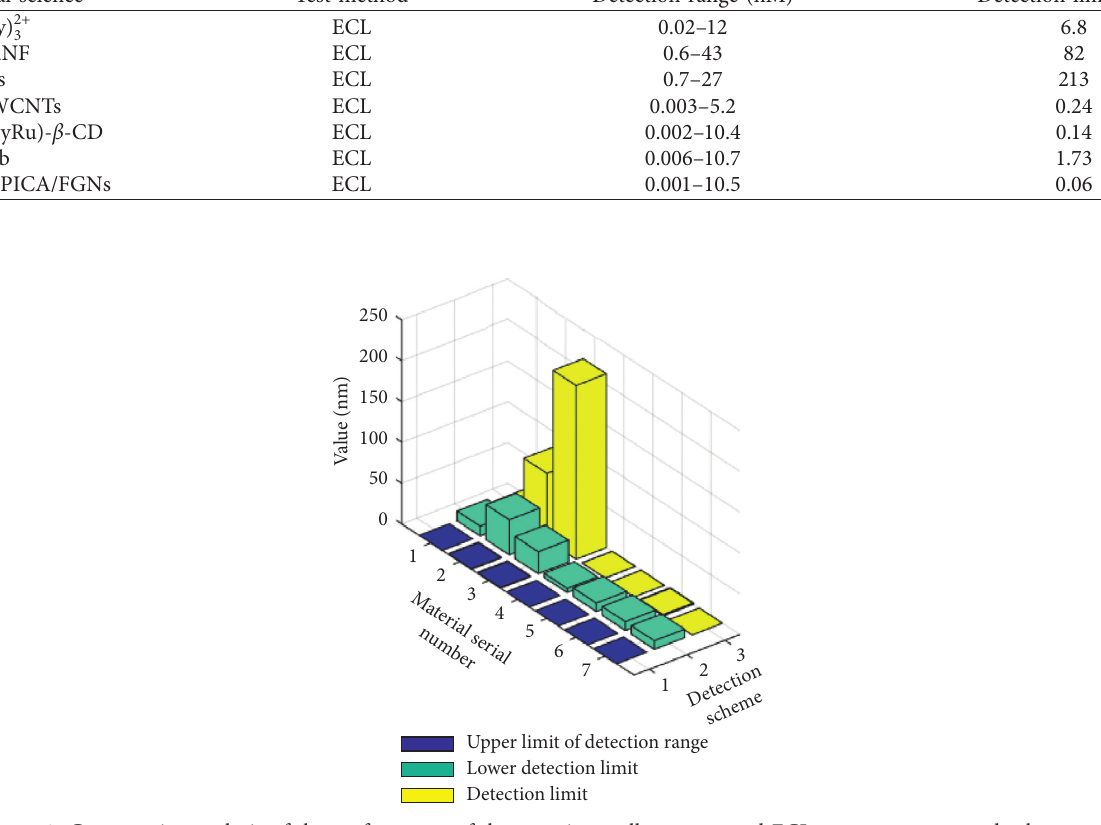
Figure 2: Comparative analysis of the performance of the experimentally constructed ECL aptamer sensor and other sensors.